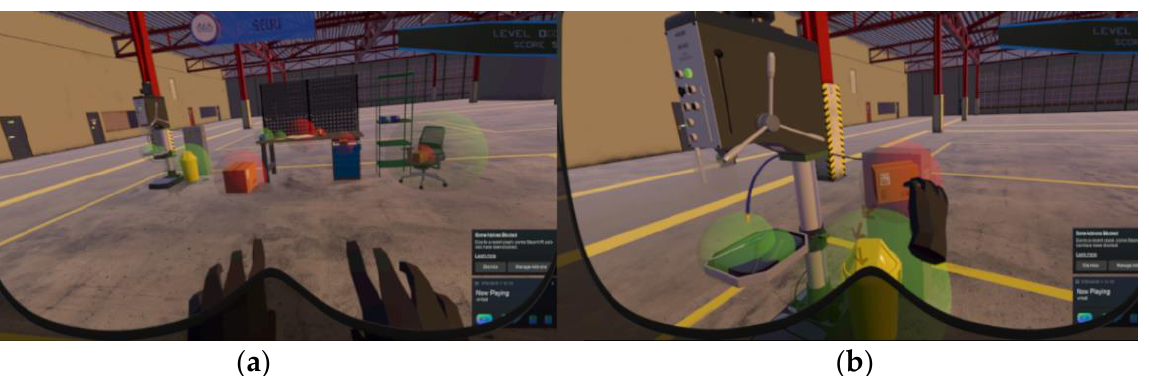
Figure 4. Level 1 ( a ) sorting the objects; ( b ) putting unnecessary objects to the bin.